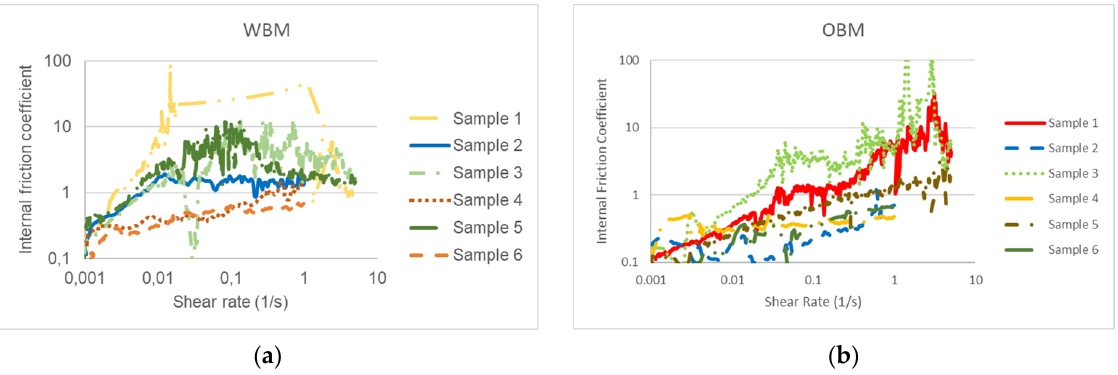
Figure 4. Cuttings bed internal friction coefficient under a constant plate–plate gap in ( a ) the WBM and ( b ) OBM.